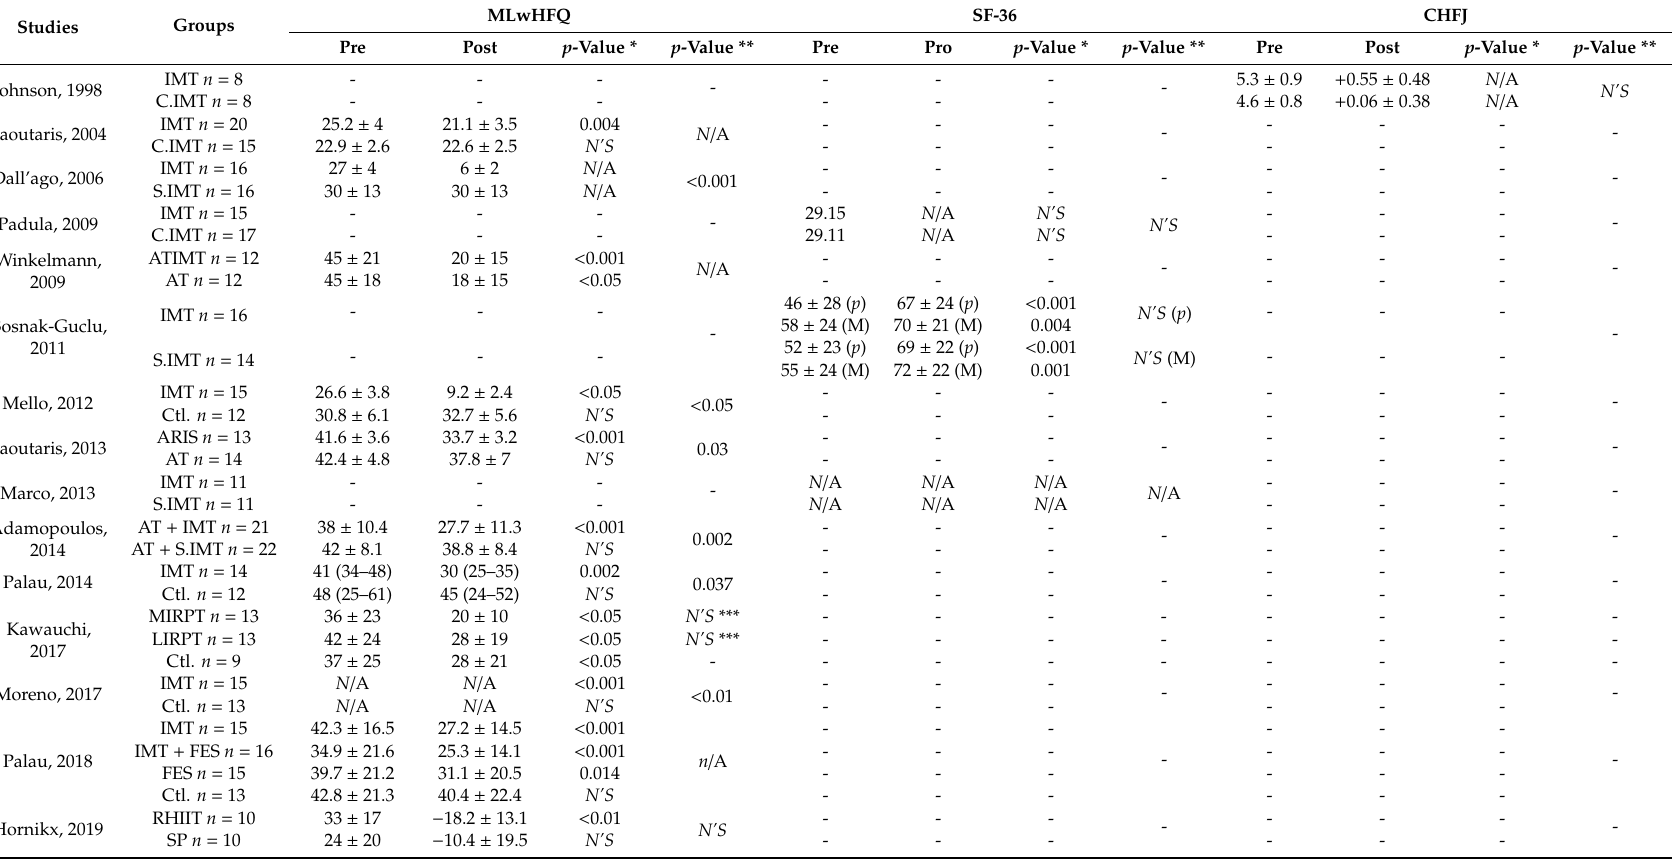
Table 9. Quality of